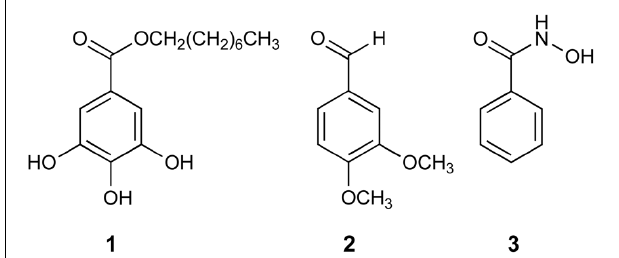
FIGURE 1 | Structures of benzo analogs used in this study. (1) octylgallate (OG); (2) veratraldehyde (VT); (3) benzohydroxamic acid